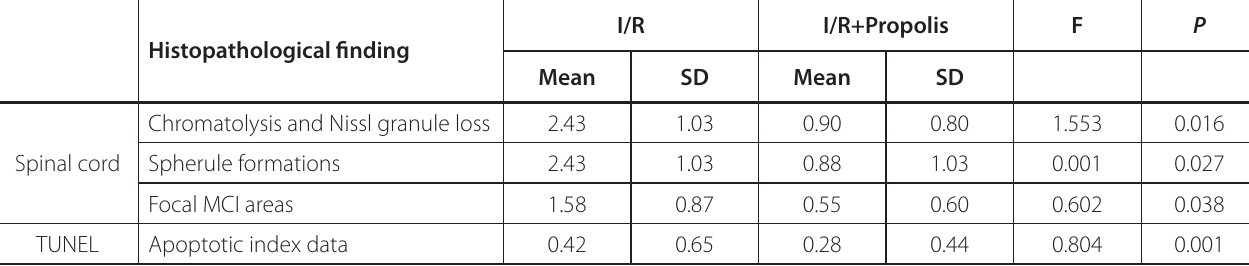
Table 4 . Histopathological evaluation of propolis in spinal cord ischemia/reperfusion injury in rabbits. Histopathological finding